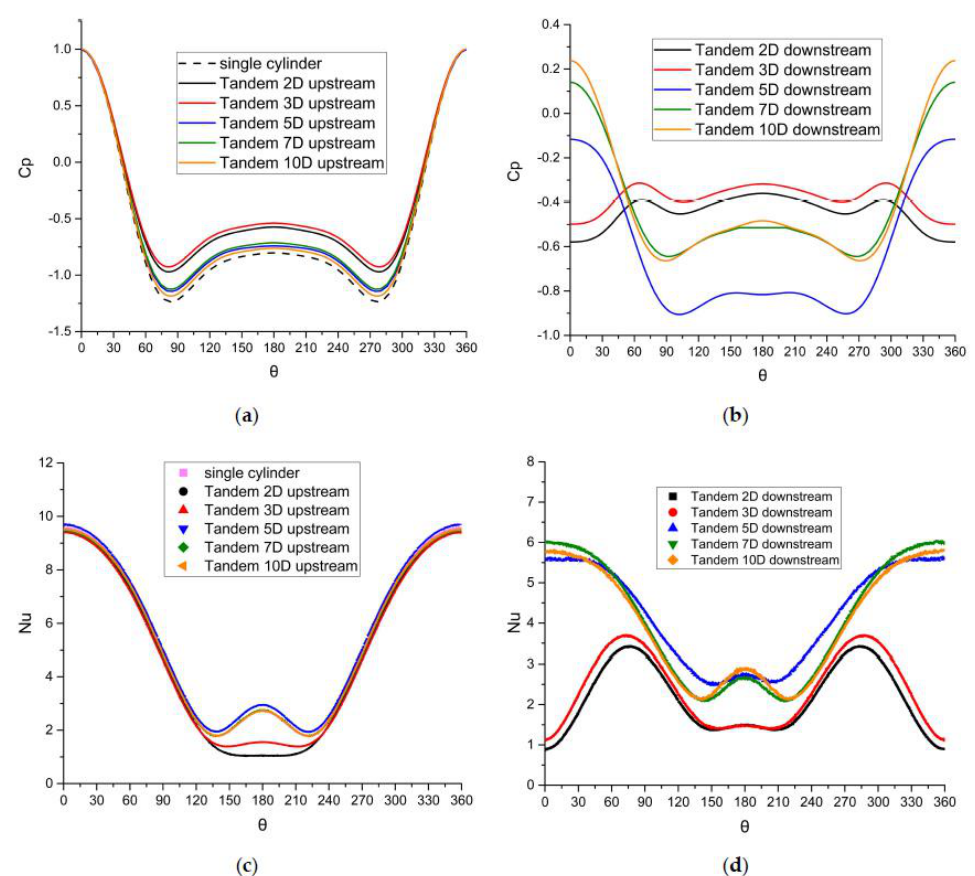
Figure 12. Time mean pressure and Nusselt number distributions of two cylinders in the different distance ratios, Re = 100: ( a ) surface pressure distribution on the upstream cylinder; ( b ) surface pressure distribution on the downstream cylinder; ( c ) Nusselt number distribution on the upstream cylinder; ( d ) Nusselt number distribution on the downstream cylinder.